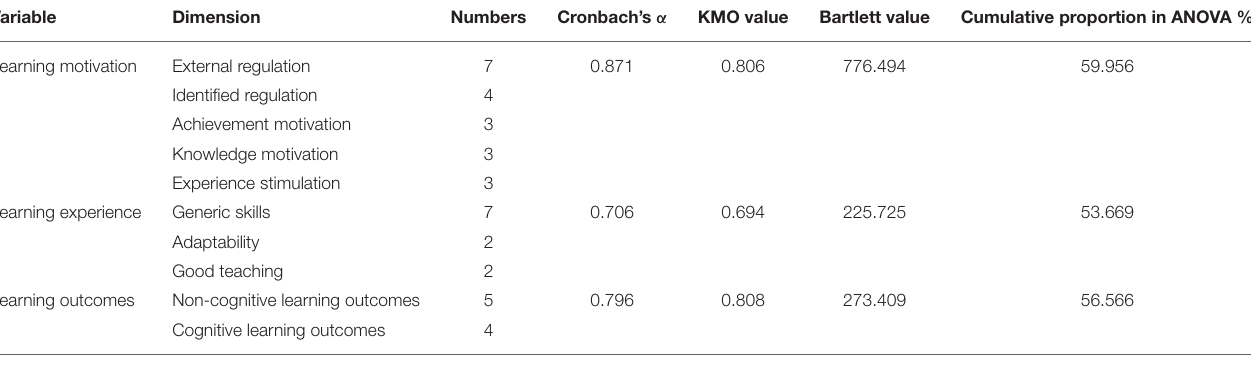
TABLE 2 | The factors and reliability/validity tests.